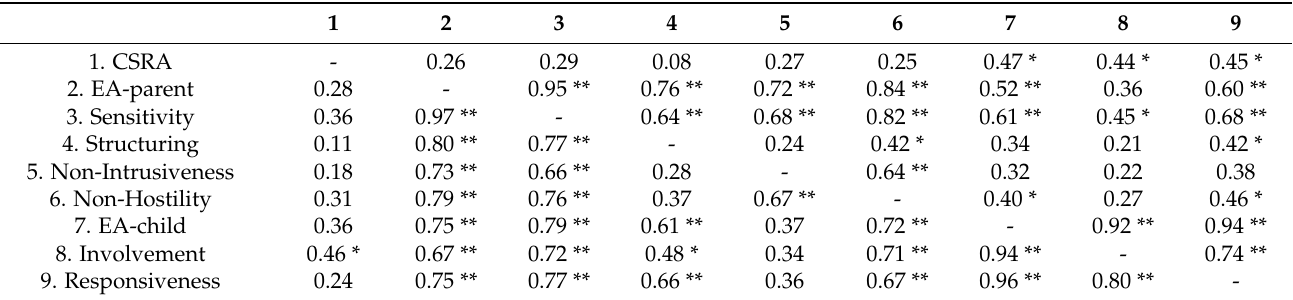
Table 3. Correlations between secure representations of attachment and emotional availability for mothers (upper right corner) and fathers (lower left